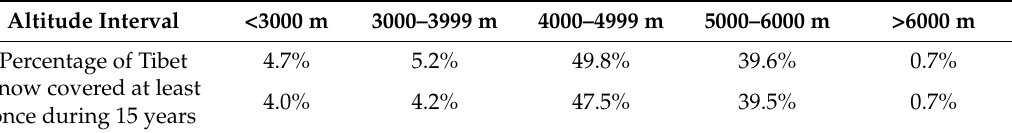
Table 4. Altitude intervals, their percentage of Tibet’s area and the area (percentage of Tibet’s area) of each interval that was snow covered during 2001–2015.